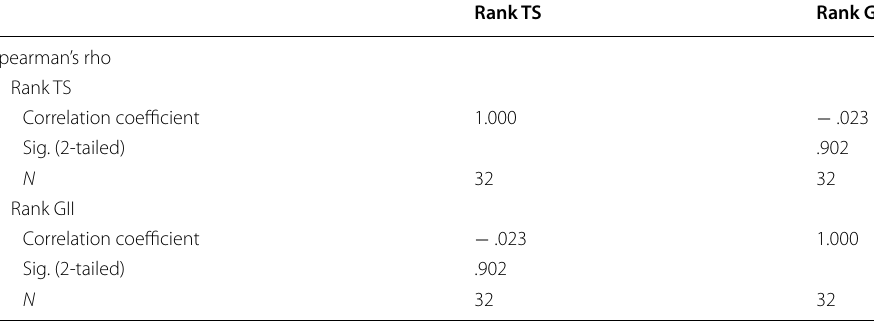
Table 2 Correlations ranks data Gelfand et